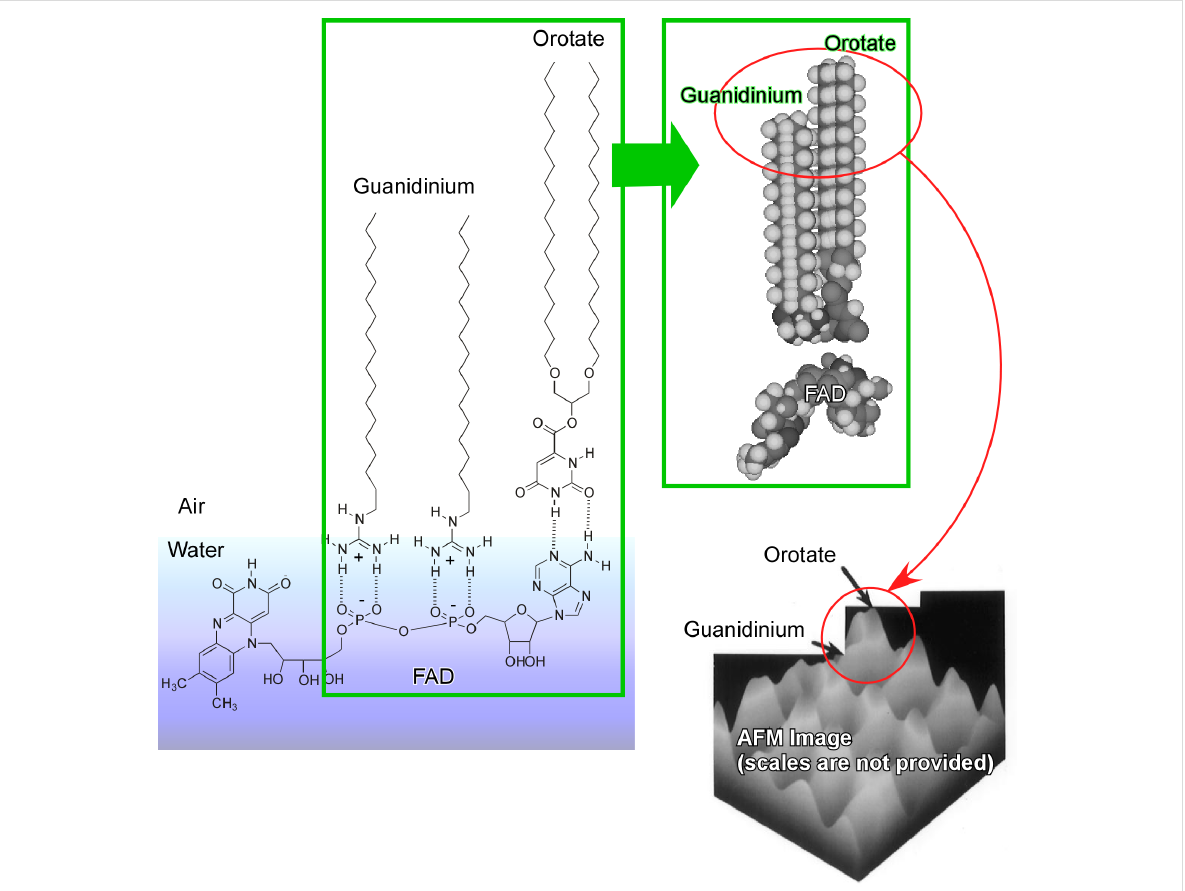
Figure 5: Formation of two-dimensional patterned structures using flavin adenine dinucleotide (FAD), which can bind site-specifically to two mono- layer components, a guanidinium lipid or an orotate lipid, with the phosphate moieties and adenosine part, respectively. Adapted with permission